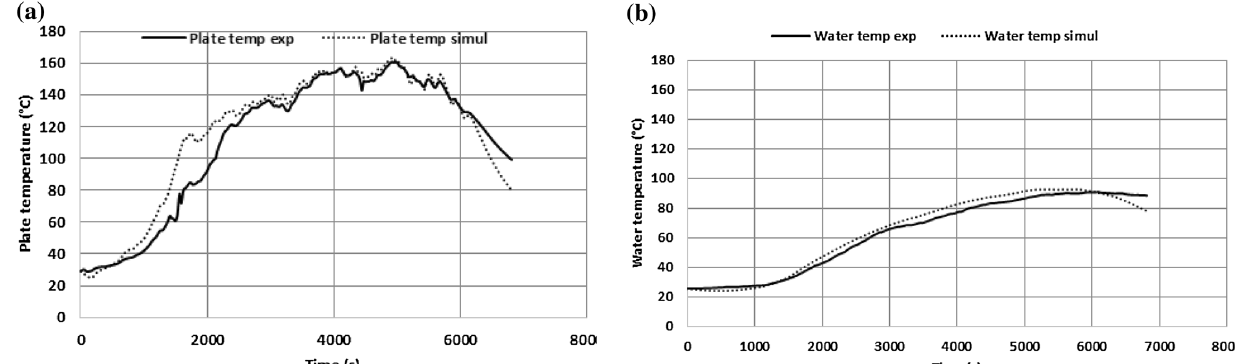
Fig. 11 Experimental (solid line) and simulated (dotted line) plate a) and water b) temperatures during a water ebullition test, in the plate